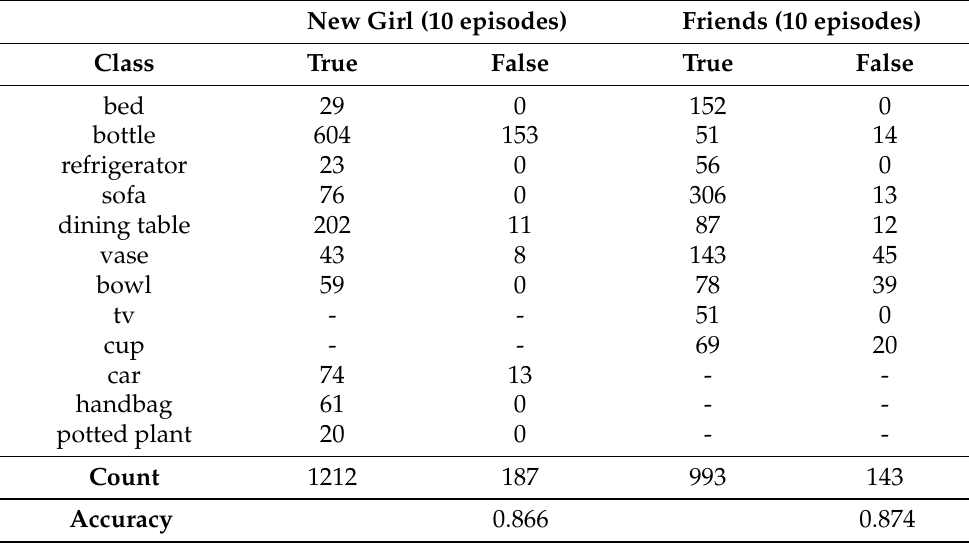
Table 3. Performance evaluation of object re-ID.